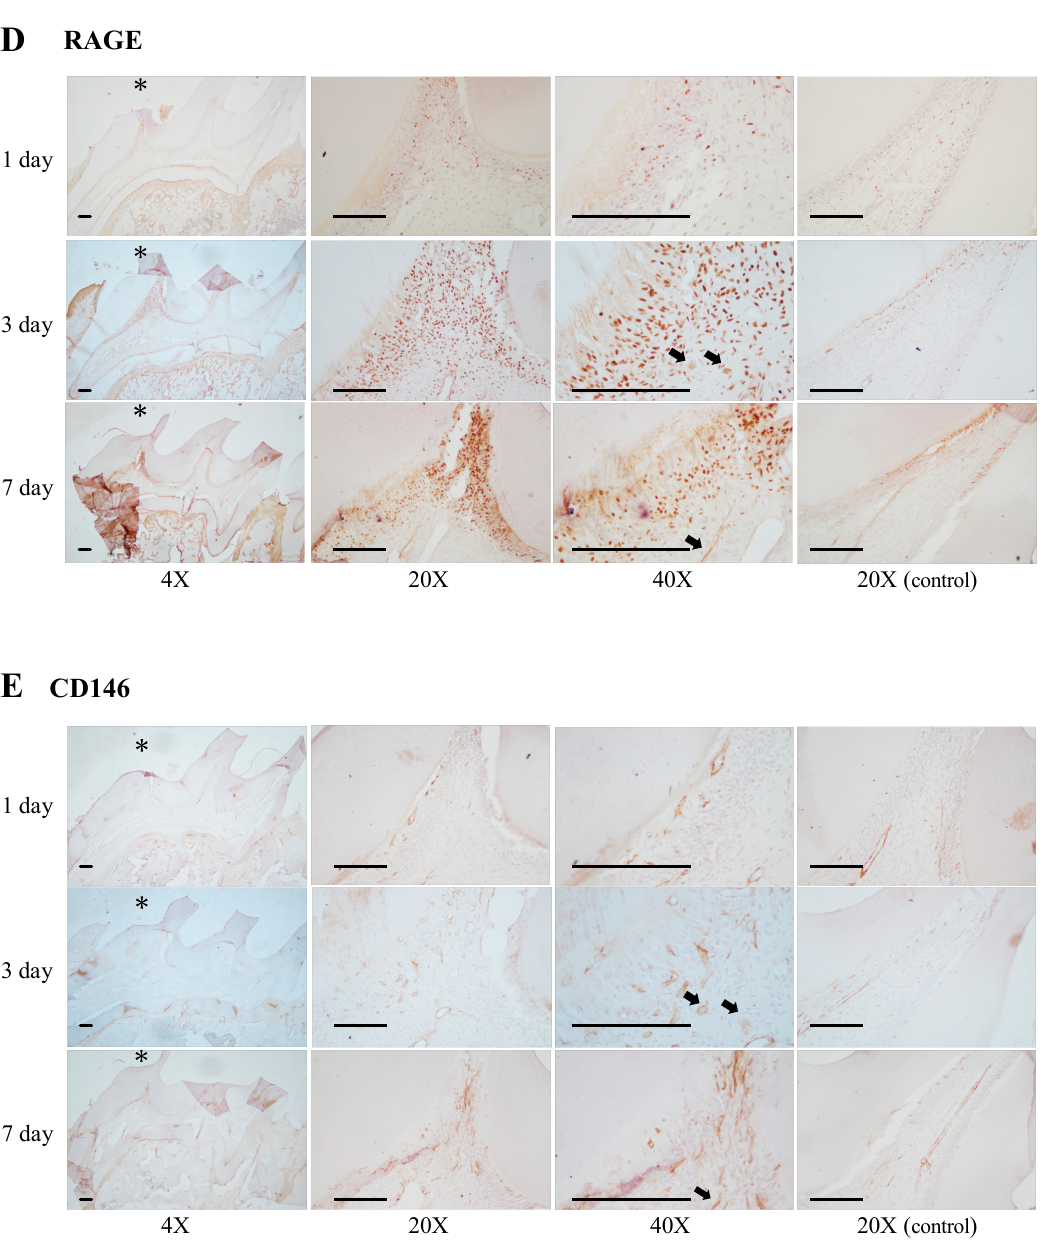
Figure 6. Localization of protein S100-A7-related proteins in the wound healing process. ( A ) Three-dimensional reconstruction of a cavity-prepared tooth. ( B ) Panoramic and high-power H-E-stained images of pulp tissue after cavity preparation. Detachment or disappearance of odontoblasts is indicated by black arrow heads and reattachment of newly differentiated odontoblast-like cells is indicated by white arrow heads. Black arrows indicate the ‘normal’ predentin area, and white arrows indicate the cavity affected predentin-like area. Immunohistochemical staining of S100-A7 ( C ), receptor for advanced glycation end-products (RAGE) ( D ), and CD146 ( E ). Pulp horn tissue of the non-cavity side was used as an internal control. Dual-positive cells for RAGE and CD146 are indicated by black arrows (D,E). Scale bar: 100 μ m (* = prepared cavity; # = tertiary dentin). Images are representative of three independent experiments.